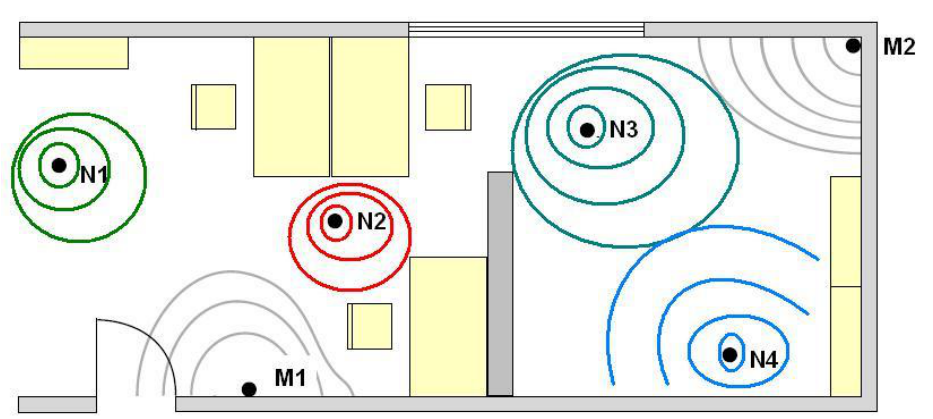
Figure 2. Illustration of wireless sensor network with possible